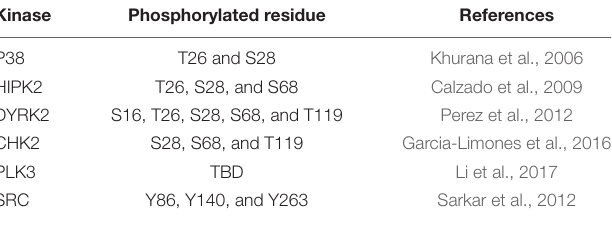
TABLE 1 | Phosphorylation sites of SIAH2 by protein